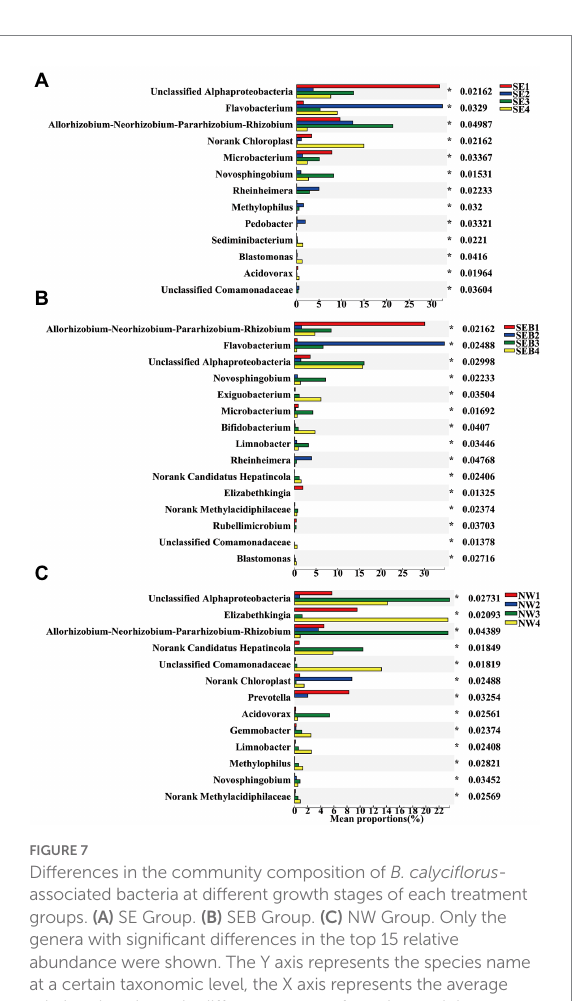
FIGURE 6 The co-occurrence network of three groups of B. calyciflorus - associated bacterial communities based on correlation analysis. (A) SE Group, (B) SEB Group, (C) NW Group. A connection stands for a strong and significant (Spearman’s p > 0.5, p < 0.05) correlation. The nodes represent unique OTUs and colored according to order. Green edges represent positive correlations and red edges represent negative correlations. Node size is proportional to the betweenness centrality of each OTU, and edge thickness is proportional to the weight of each correlation.